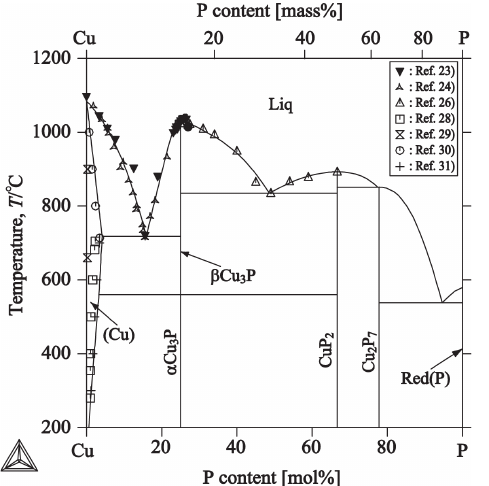
Figure 1. Calculated binary phase diagram of the Cu-P system.